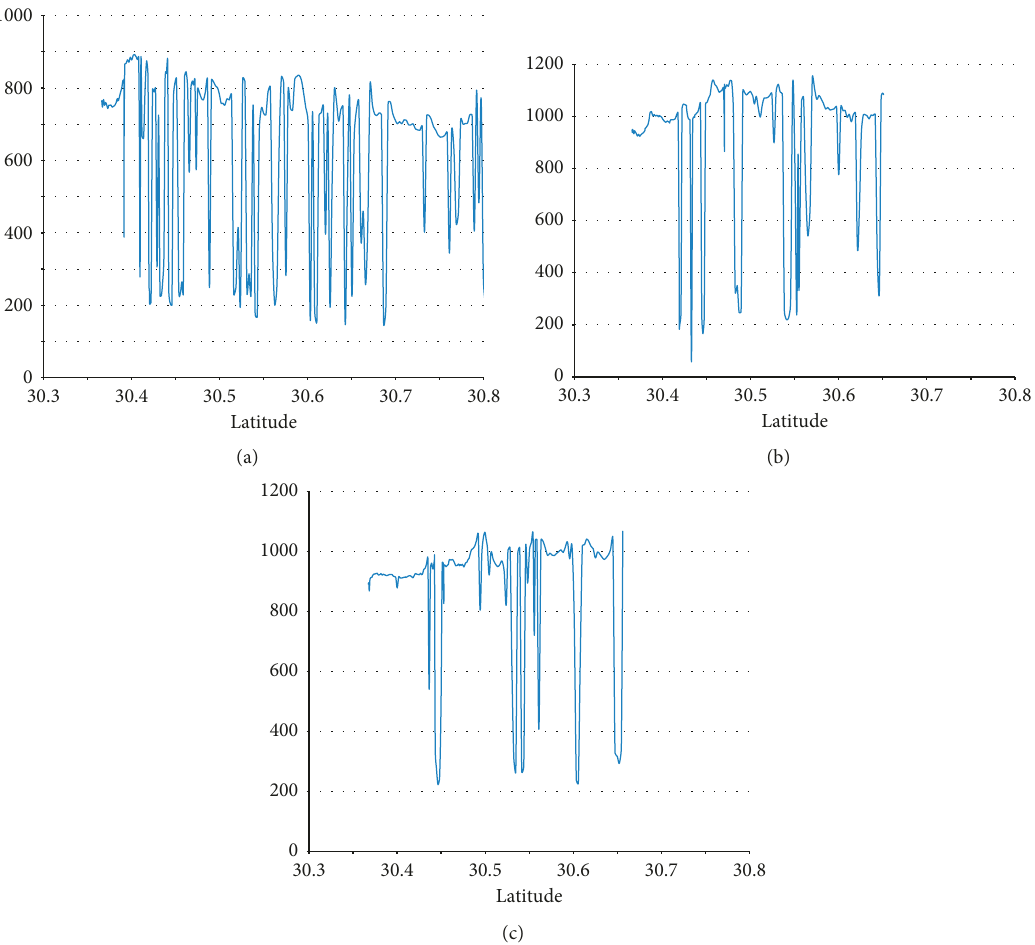
2 ) from 10 August 2015. (a) Southbound Wiggins-Gulfport from 1435 to 1527 Figure 14: Space series of incoming solar radiation (W/m UTC (0935–1027 CDT). (b) Northbound Gulfport-Saucier from 1617 to 1651 UTC (1117–1151 CDT). (c) Southbound Saucier-Gulfport − from 1833 to 1908 UTC (1333–1408